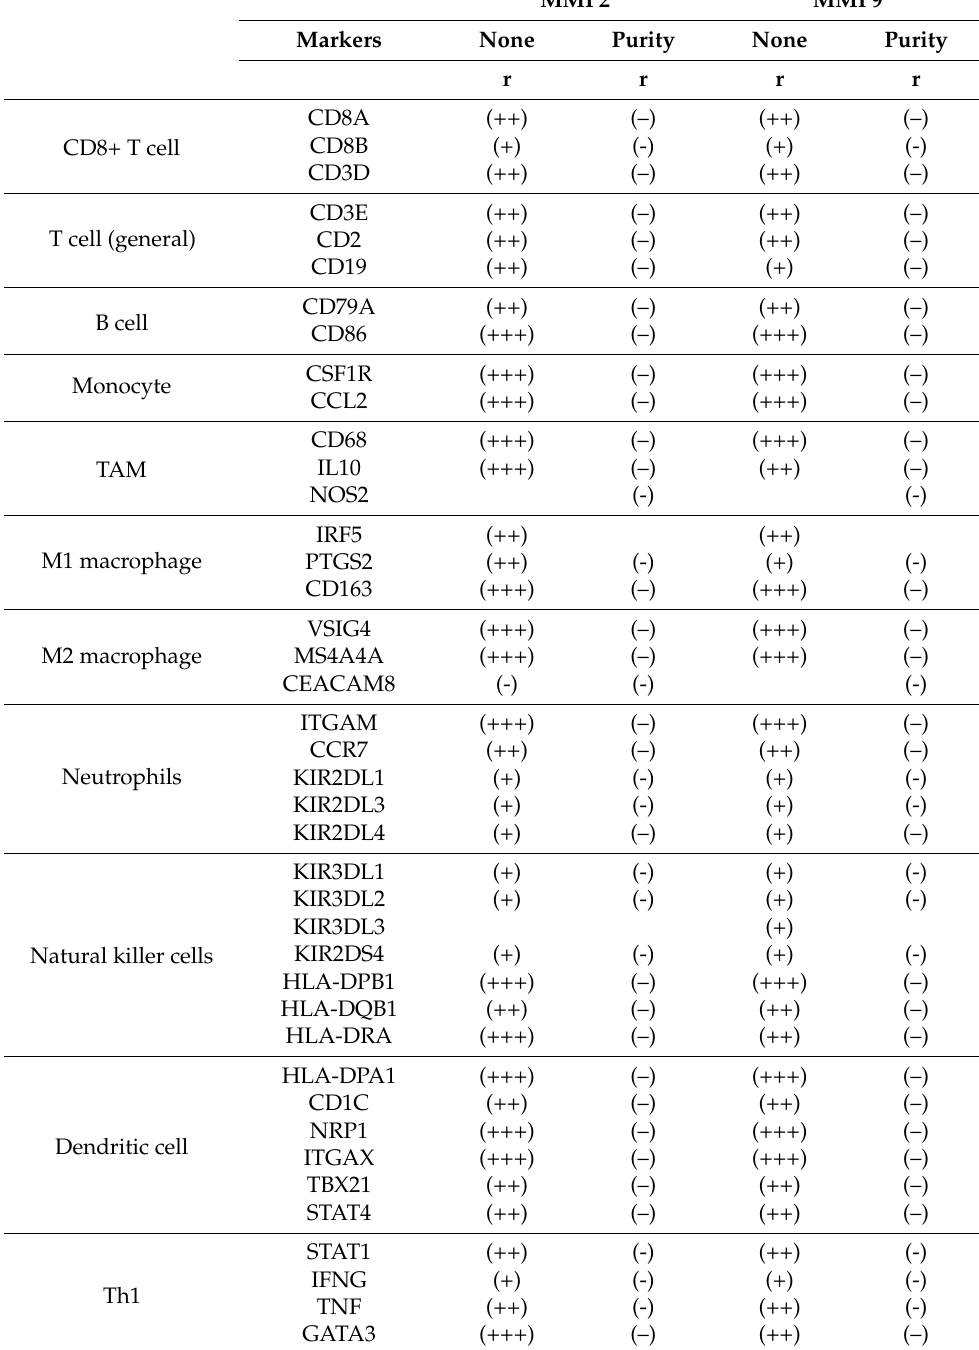
Table 5. Correlation analysis between MMP2 and MMP9 expression and related genes and markers of infiltrating immune cells using the TIMER database. None, correlation without adjustment; purity, correlation adjusted by purity. r, the categorized Pearson’s correlation coefficient, was scored as follows: (—), r from − 1.0 to − 0.5, strong negative association; (–), − 0.5 to − 0.3, weak negative associa- tion; (-), − 0.3 to 0.1, little association. (+), +0.1 to 0.3, little association; (++) +0.3 to +0.5, weak positive association; (+++), +0.5 to +1.0, strong positive association. p -value indicates statistical significance. MMP2 MMP9 Markers